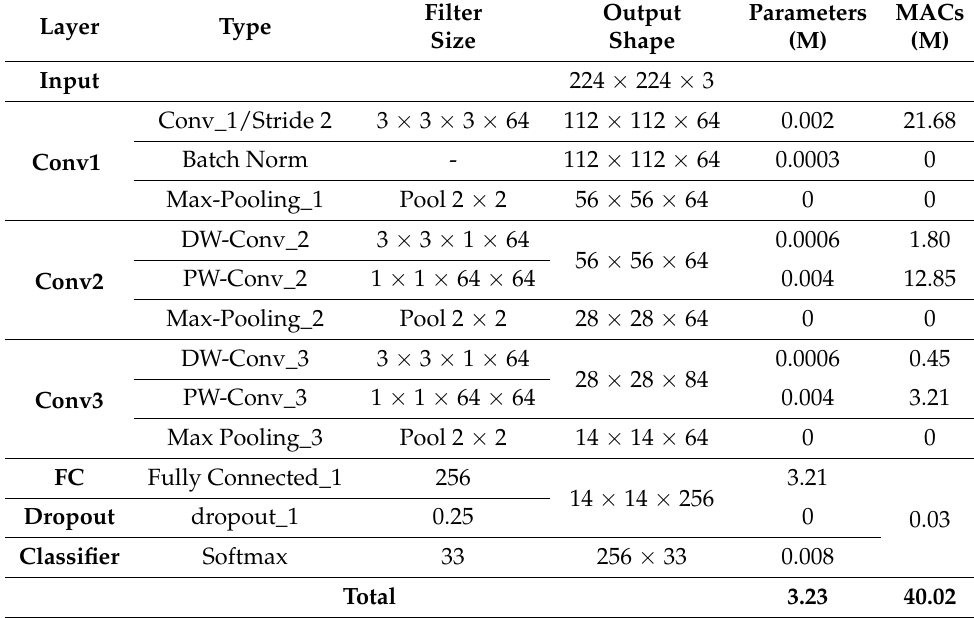
Table 1. The proposed architecture